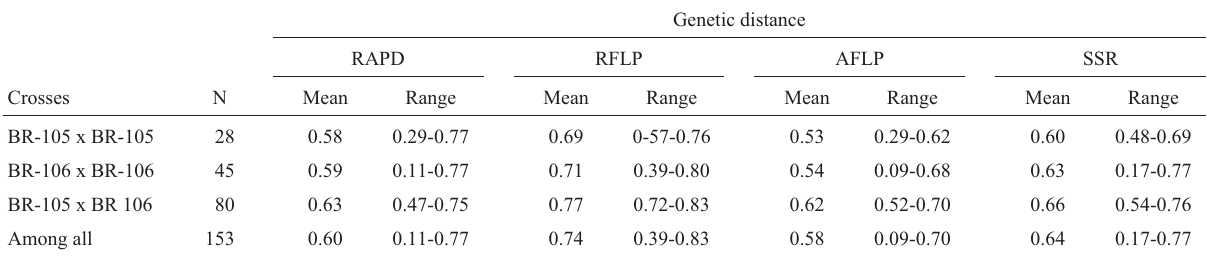
Table 1 - Mean and range of the genetic distance values for different maize crosses calculated using data from random amplified polymorphic DNA (RAPD), restriction fragment length polymorphism (RFLP), amplified fragment length polymorphism (AFLP) and simple sequence repeat (SSR) markers. The Jaccard similarity coefficient was used for dominant markers and Roger’s modified distance for codominant